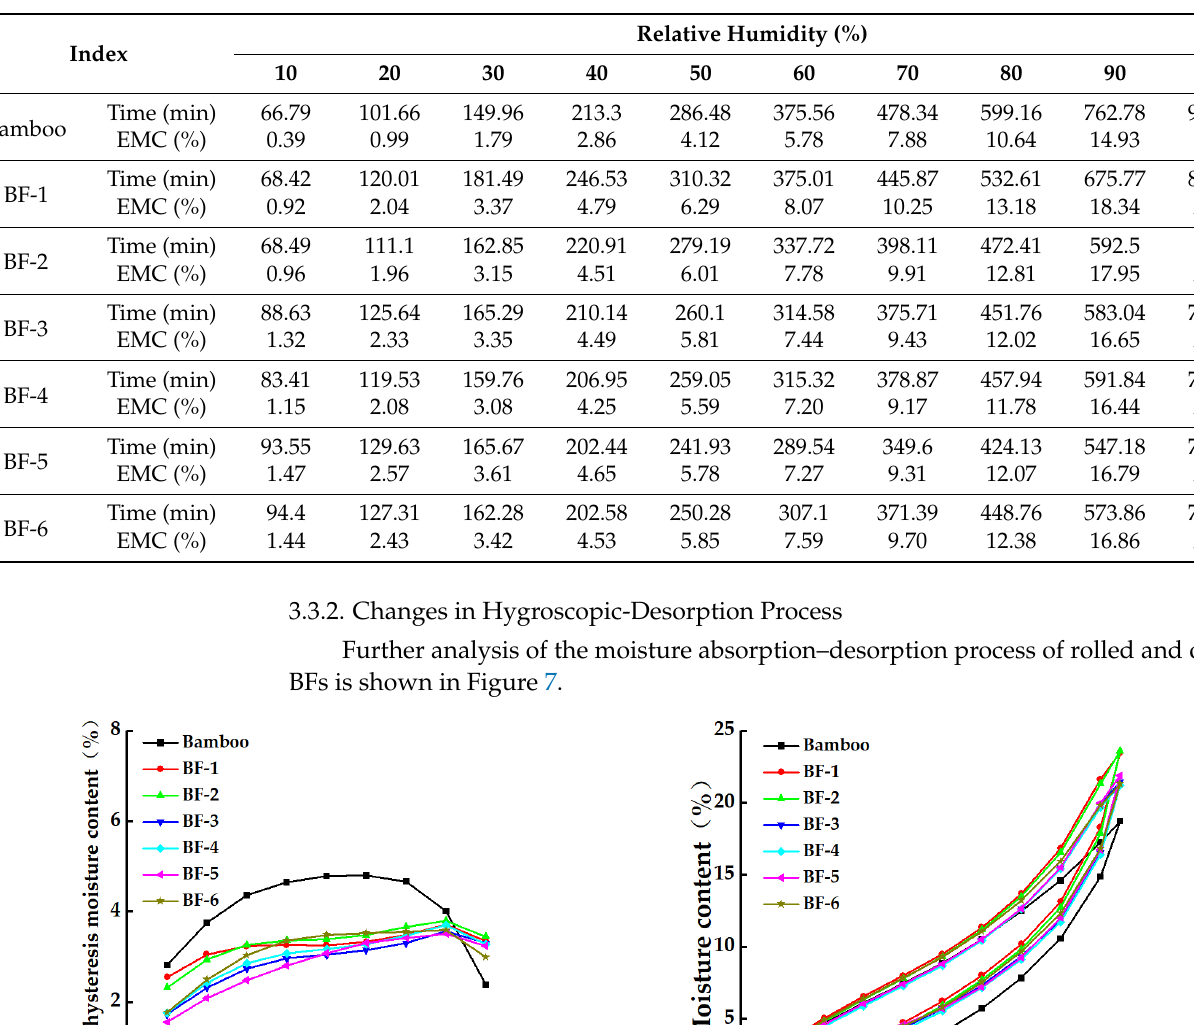
Table 2. Moisture-adsorption equilibrium parameters of bamboo fibers with different opening times.